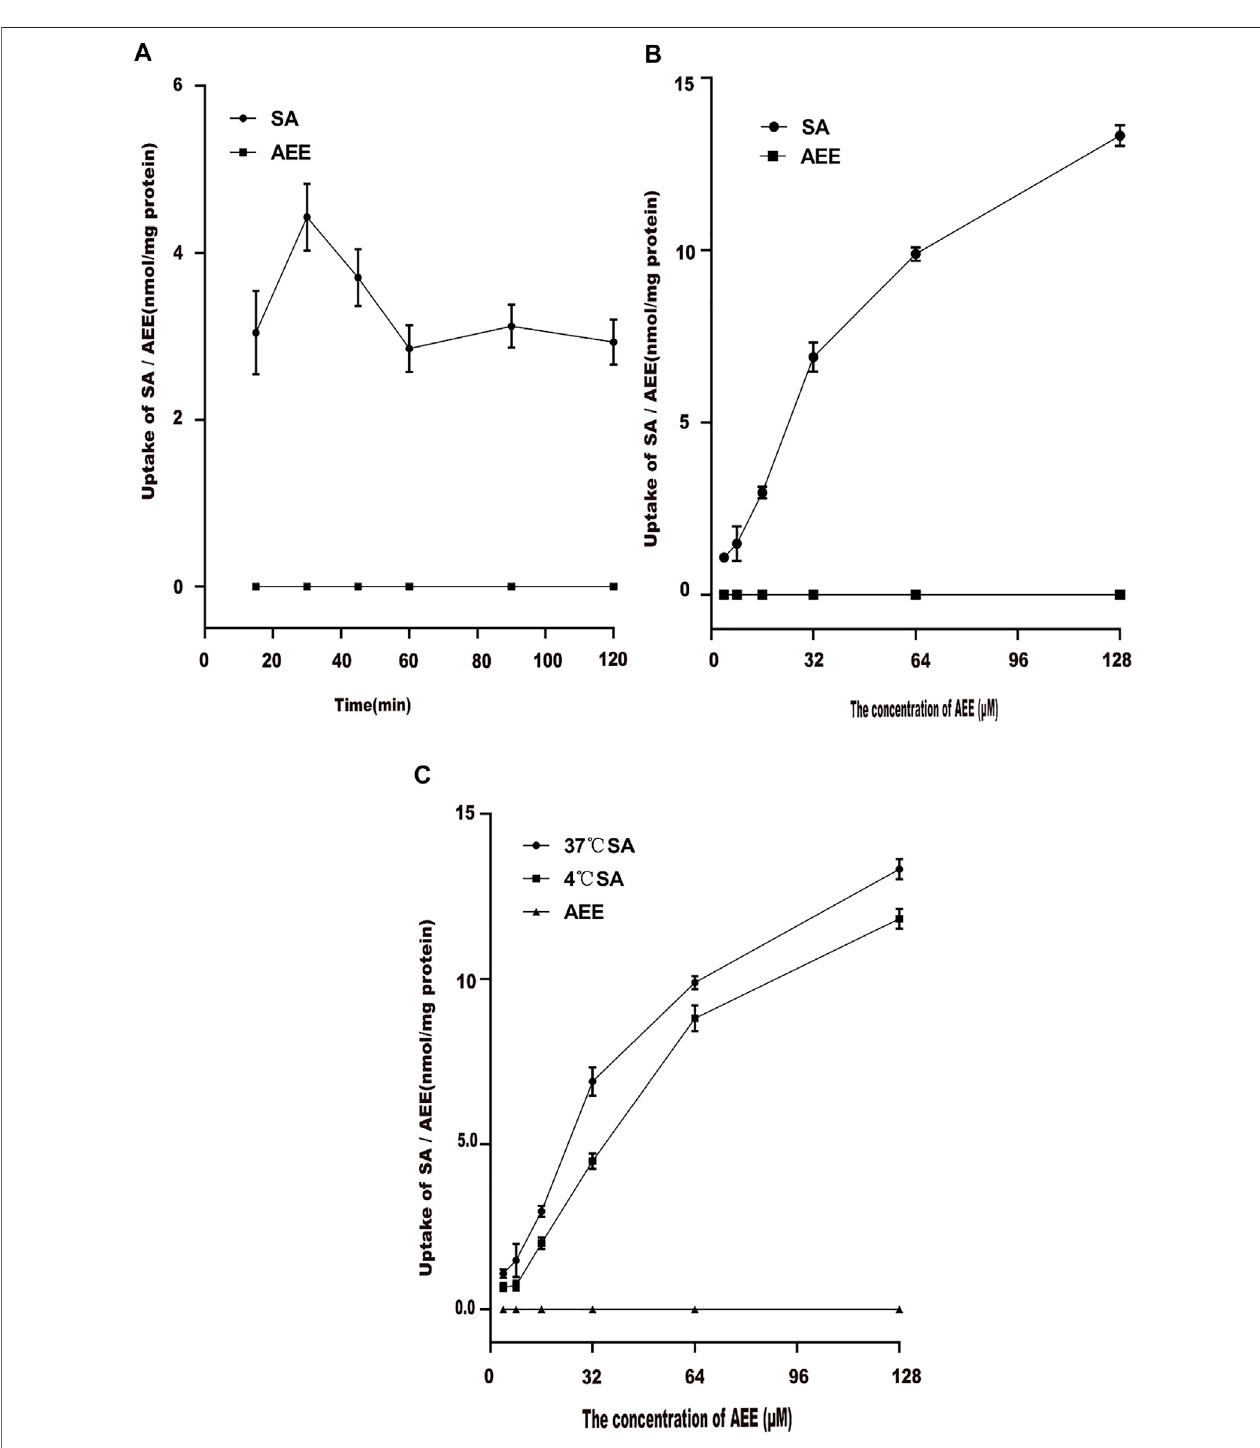
FIGURE 4 | Effect of different factors on the uptake of AEE in the Caco-2 cell model. The main active metabolite of AEE as salicylic acid represented for AEE was quanti fi edafteradministration. (A) EffectoftimesontheuptakeofAEE(64 μ M). (B) EffectofconcentrationsontheuptakeofAEEduring30 min. (C) Effectoftemperature (37 ° C and 4 ° C) on the uptake of AEE during 30 min. Values are presented as the means ± SD where applicable ( n = 6). * p < 0.05 compared with 4 ° C.